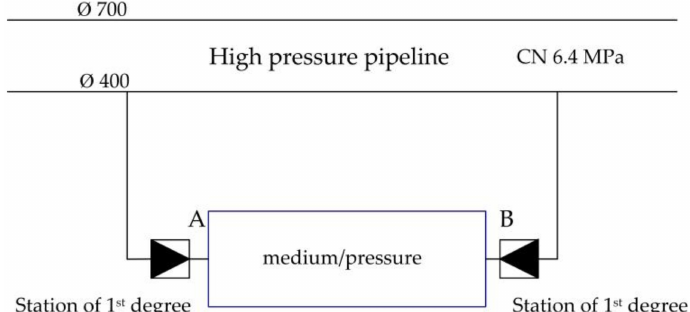
Figure 6. The gas-supply system (GSS) power scheme for the distinguished city, where h/p is a high-pressure gas pipeline, and m/p is the medium-pressure ring distribution network supplying part of the city and the second-stage reduction stations, with the first-stage stations (A, B) being reduction power stations.